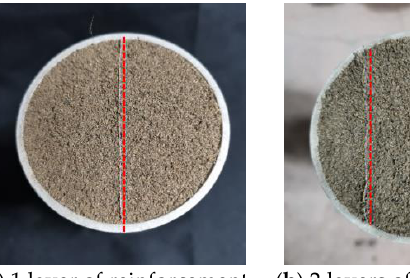
Figure 5. Preparation process of the reinforced tailings sample.